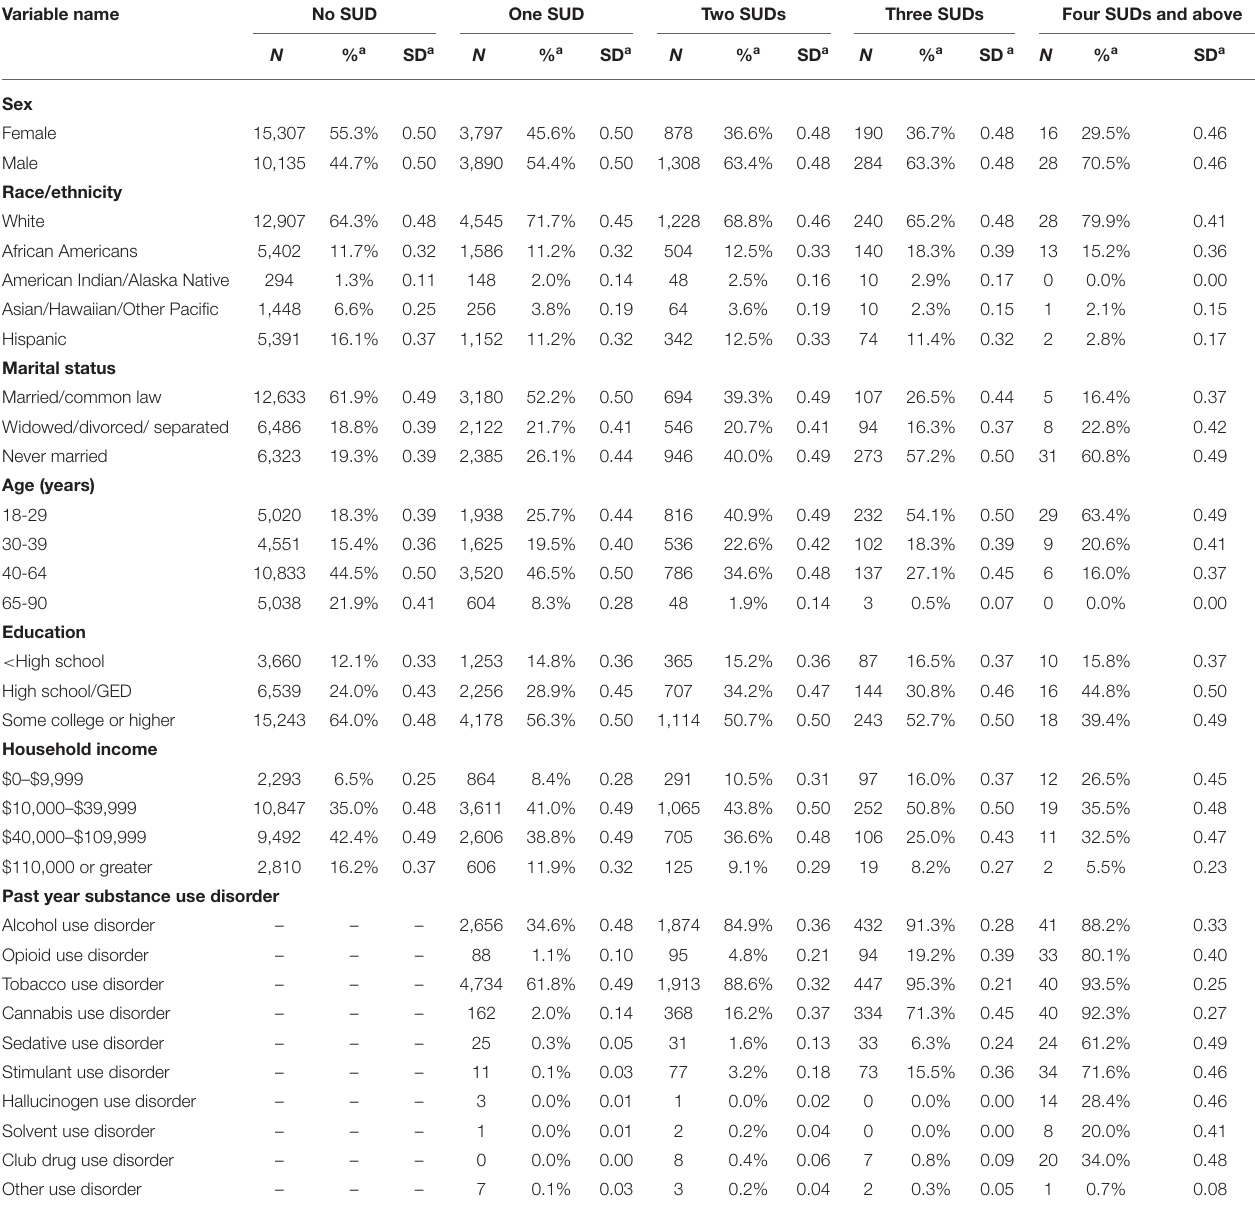
TABLE 1 | Demographic characteristics of the